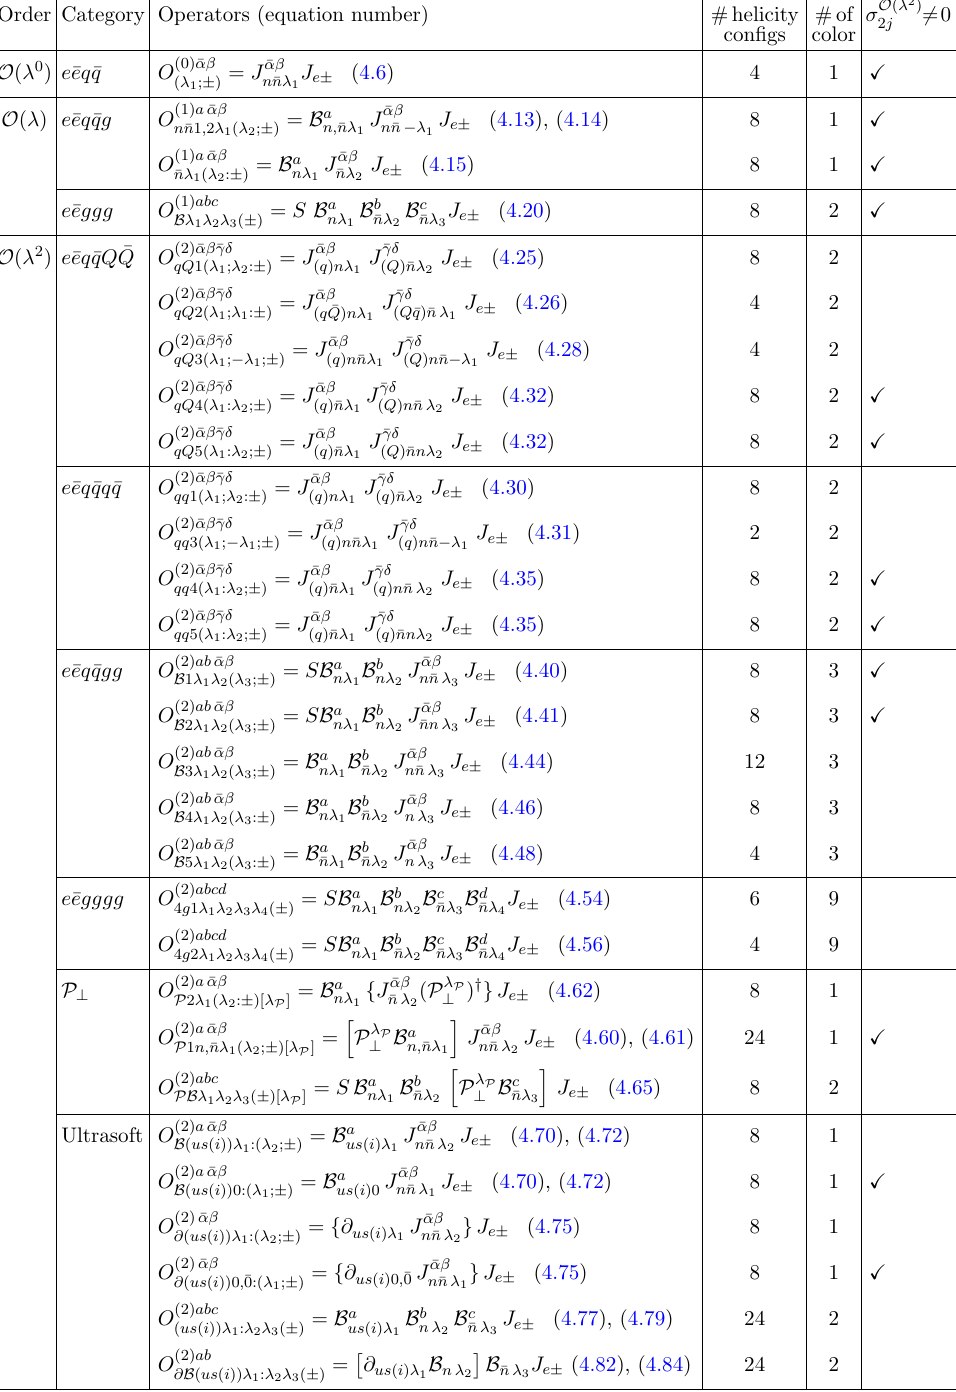
n; (cid:22) n(cid:21) 1